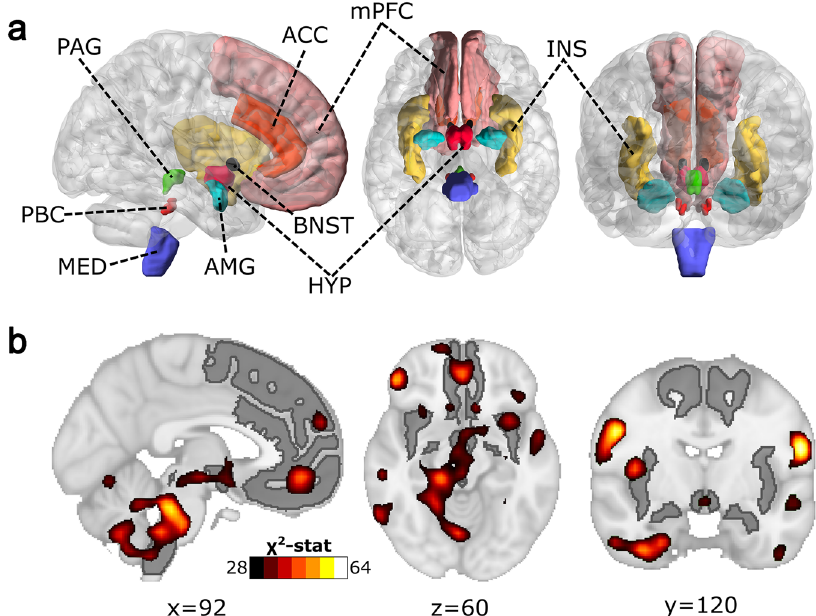
Fig. 2 Central Autonomic Network and its intersection with HRV-BOLD de-synchronization maps. a Anatomical representation of the Central Autonomic Network (CAN) created by pooling several regions extracted from different public MRI atlases (see Methods section in main text). b Statistically signi fi cant brain regions after group comparisons with the contrast patient <control in NNiqr -BOLD synchronization maps and surviving multiple comparisons. CAN network is colored in gray. The map of signi fi cant results is shown in a color scale that represents the value of the X 2 statistic of the Fisher ’ s test. Signi fi cant brain regions overlay with those belonging to CAN, including cerebellum, brainstem, lateral parietal-temporal cortex, medial prefrontal cortex, insula, hypothalamus, and anterior cingulate cortex (see Results section in main text for further details). HYP hypothalamus, INS insular cortex, ACC anterior cingulate cortex, AMG amygdala, mPFC medial prefrontal cortex, PAG periaqueductal gray matter, MED medulla, PBC parabrachial complex, BNST bed nucleus of the stria